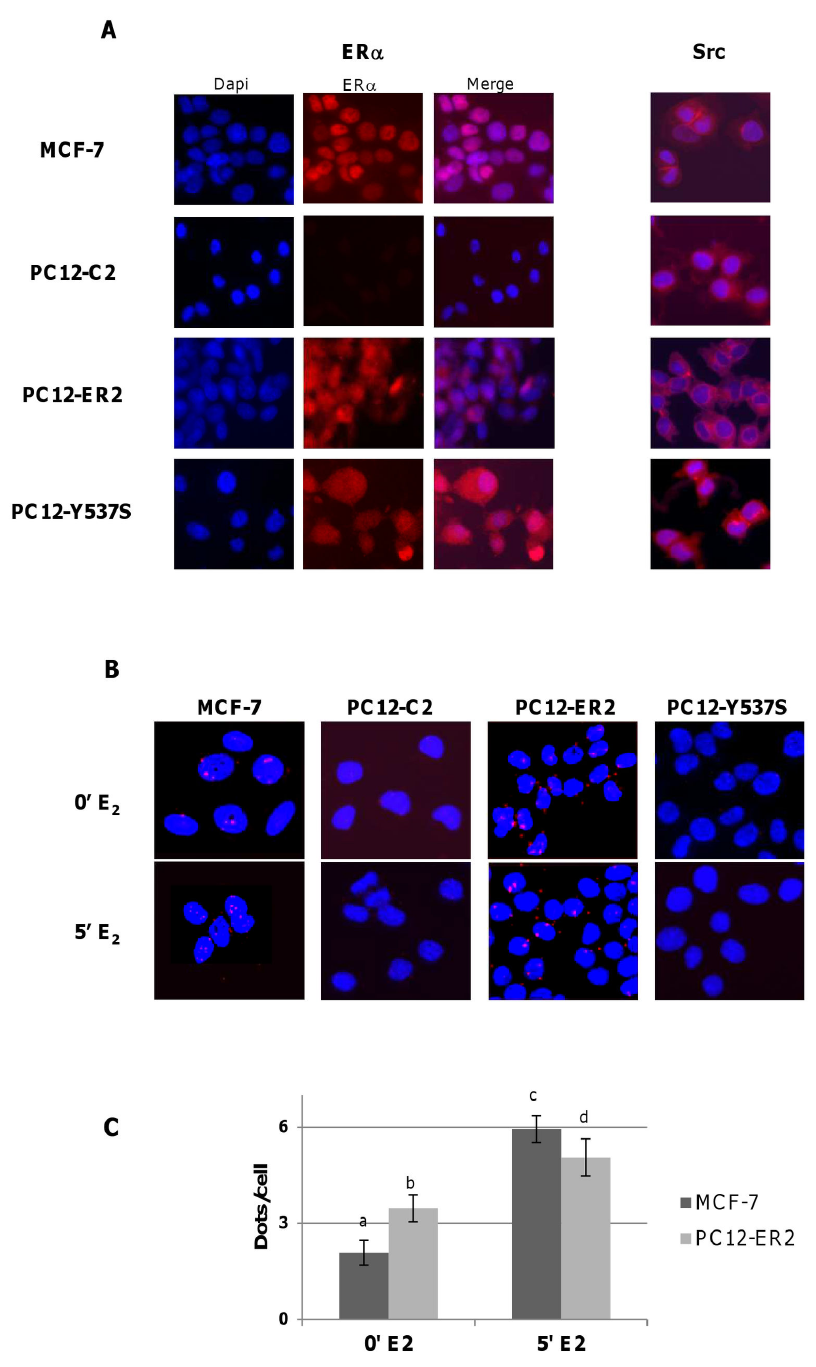
Figure 5. In situ PLA detection of endogenous ERα/Src interaction in PC12 and MCF7 cells. A) - Immunocytochemistry for ERα (left panels) and Src (right panels) in MCF7, PC12-C2, PC12-ER2 and PC12-ER-Y537S, grown in medium containing 5% of charcoal stripped serum. The nuclei were counterstained with Dapi (blue) (Obj: X20). B) - In situ PLA for ERα/Src dimers in MCF7, PC12-C2, PC12-ER2 and PC12-ER-Y537S grown in medium containing 5% of charcoal stripped serum with vehicle (upper panels) or with E (10 -8 M) for 5 min (lower panels). The detected dimers are represented by red dots and the nuclei were counterstained 2 with Dapi (blue). C) - Quantification of PLA signals per cell was performed by computer-assisted analysis as reported in the Materials and Methods section. Values correspond to the mean ± SEM of at least three separate experiments (10 fields; more than 500 cells/experiment). Columns with different superscripts differ significantly (p<0.05 by Student test). doi: 10.1371/journal.pone.0069081.g005 PLOS ONE |